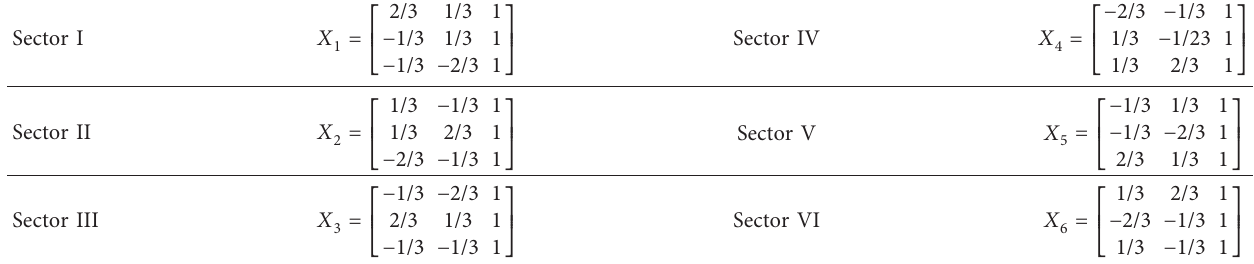
Table 4: Transition matrix [ k AN , k BN , k CN ] and [ k x , k y , CMV].